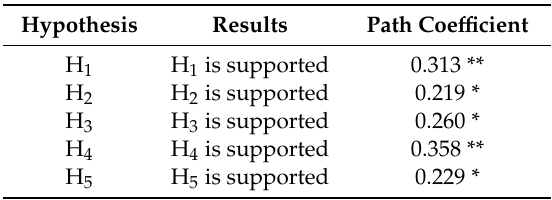
Table 6. Path coe ffi cient